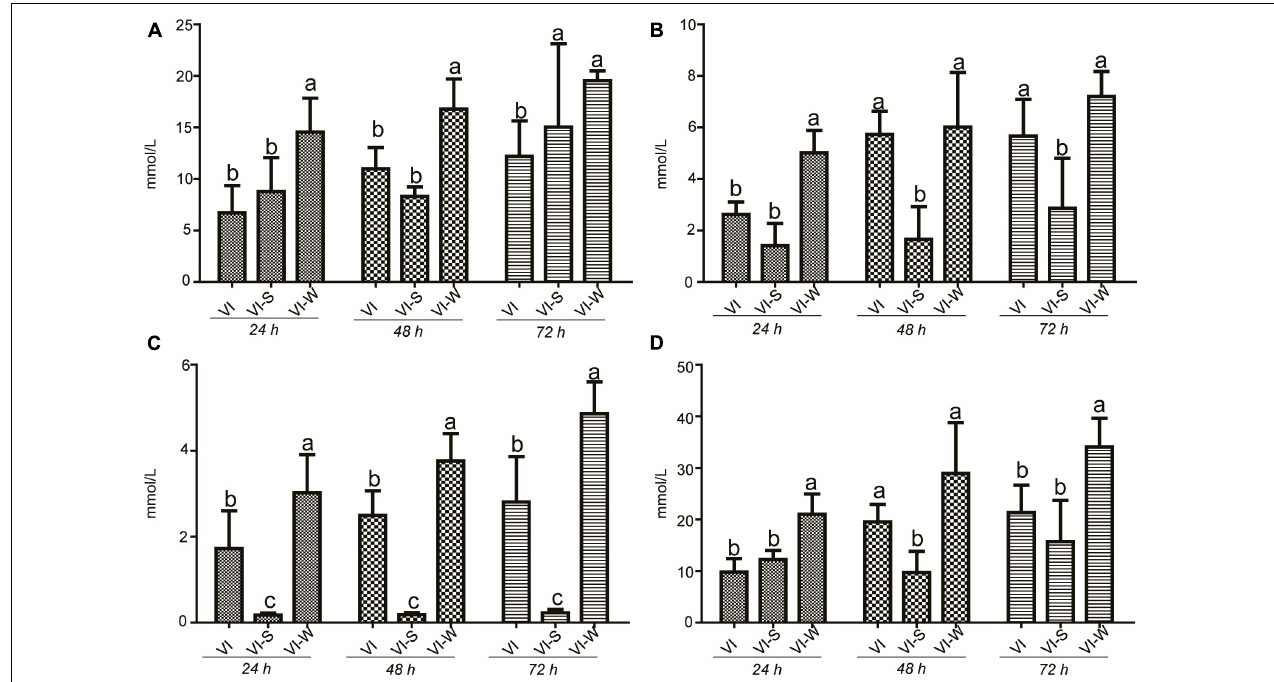
FIGURE 5 | Influence of EPS-m2 fermentation on SCFA production. The concentration of (A) acetic acid, (B) propionic acid, (C) butyric acid, and (D) and total SCFAs were measured using gas chromatography, and total SCFA represents the summary of acetic acid, propionic acid and butyric acid. “VIW,” “VIS,” and “VI” represent samples collected after EPS-m2 fermentation, starch fermentation, and no carbohydrate added, respectively. Significant differences between treatments were labeled using different normal letters. Triplicate measurements were performed for each sample in this